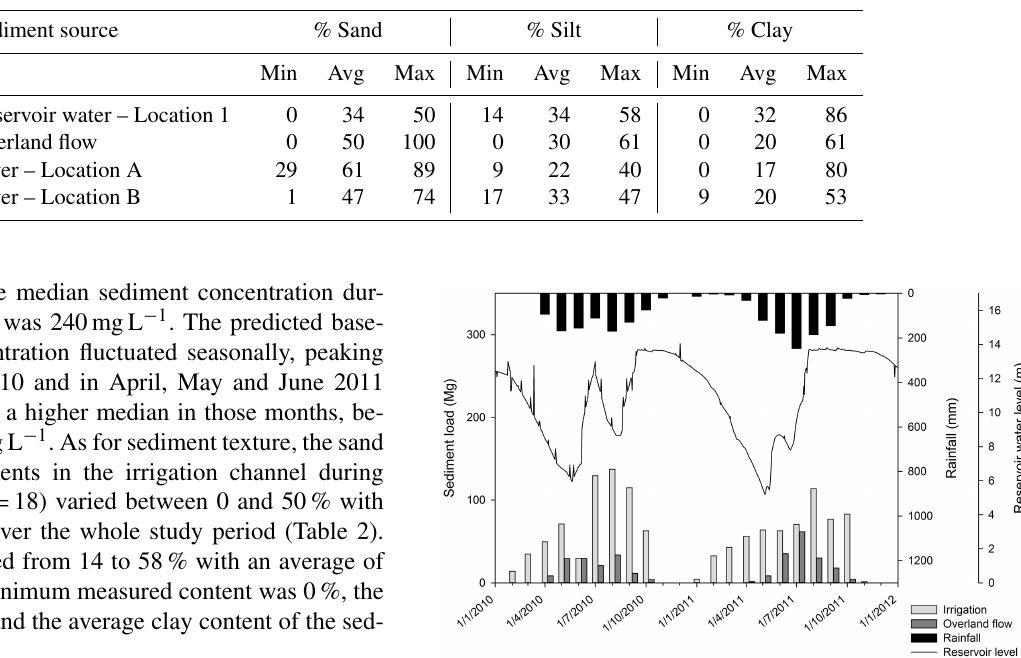
Table 2. Average sediment particle size distribution measured at the different measurement locations for the different components of the paddy area sediment balance.